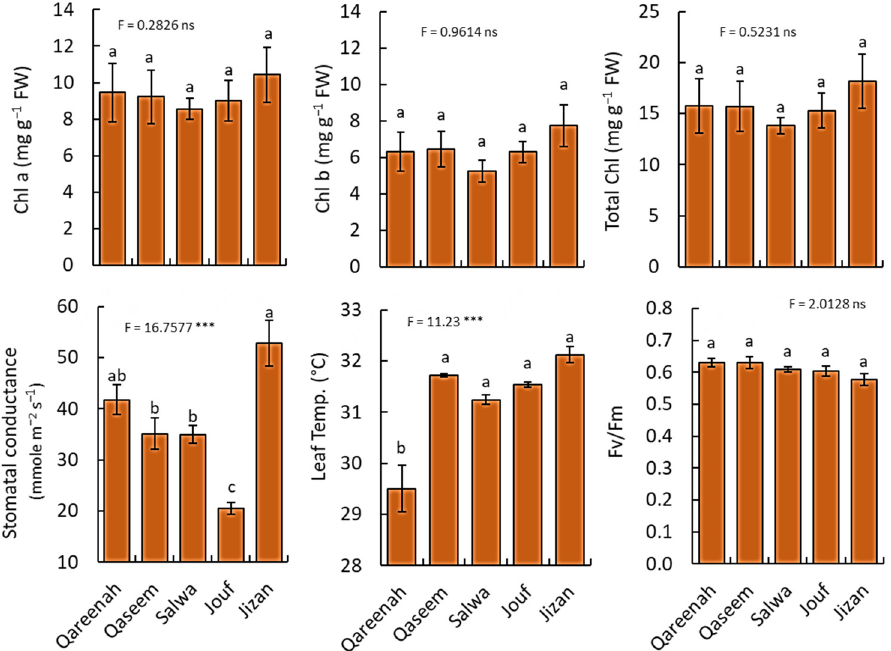
Figure 6. Ecophysiological parameters of Aeluropus lagopoides growing in different saline flat regions of Saudi Arabia. Values are average ( n = 75 ), and the bar represents the standard error. Different letters among regions showed significant differences at p < 0.05 after Duncan’s test. *** p < 0.001, and “ns” for p > 0.05. FW: fresh weight.